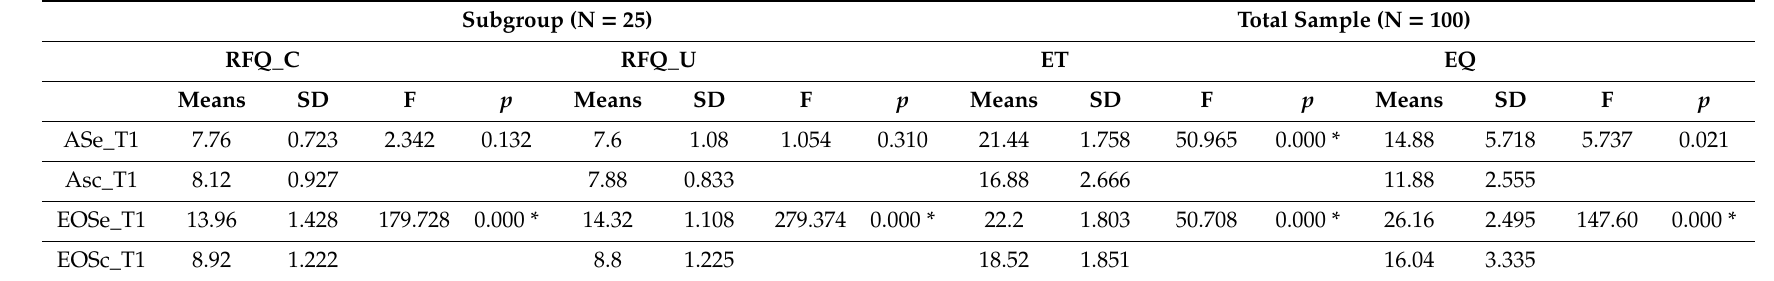
Table 4. Comparison between ASe / ASc at T1 and EOSe / EOSc at T1.